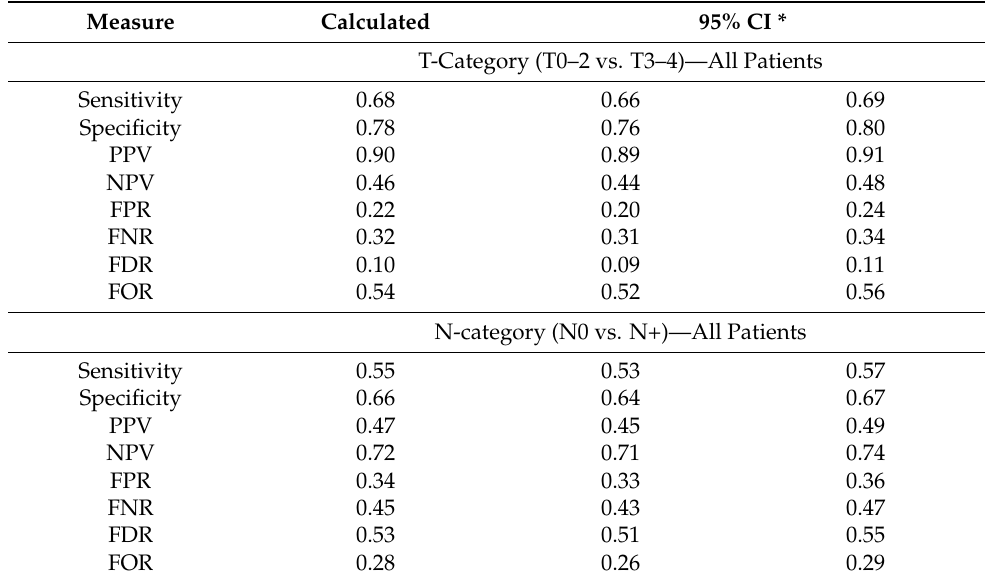
Table 2. Overall measures of accuracy, clinical vs. histopathological category in colon cancer. Measure Calculated 95% CI * T-Category (T0–2 vs. T3–4)—All Patients Sensitivity 0.68 0.66 0.69 Specificity 0.78 0.76 0.80 PPV 0.90 0.89 0.91 NPV 0.46 0.44 0.48 FPR 0.22 0.20 0.24 FNR 0.32 0.31 0.34 FDR 0.10 0.09 0.11 FOR 0.54 0.52 0.56 N-category (N0 vs. N+)—All Patients Sensitivity 0.55 0.53 0.57 Specificity 0.66 0.64 0.67 PPV 0.47 0.45 0.49 NPV 0.72 FNR FDR 0.53 0.51 0.55 FOR 0.28 0.26